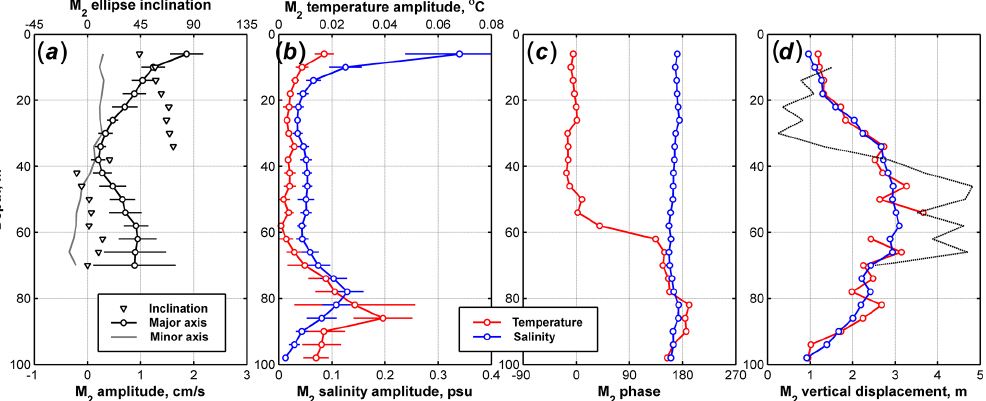
Figure 9. (a) Vertical distribution of the lunar semidiurnal (M 2 ) tidal ellipse parameters at the mooring position. Horizontal bars indicate the 95% confidence interval for major axis amplitude. (b) The tidal (M 2 ) amplitude of temperature (red) and salinity (blue) and the corresponding 95% confidence intervals. (c) The M 2 phases of temperature and salinity. (d) The vertical displacement of water parcel estimated as a ratio of M 2 tidal amplitude of temperature/salinity (red/blue) to the vertical gradients of temperature/salinity estimated from the mean vertical profiles in Fig. 6a, b. Dotted black line shows the vertical displacements estimated from the lunar semidiurnal component of vertical